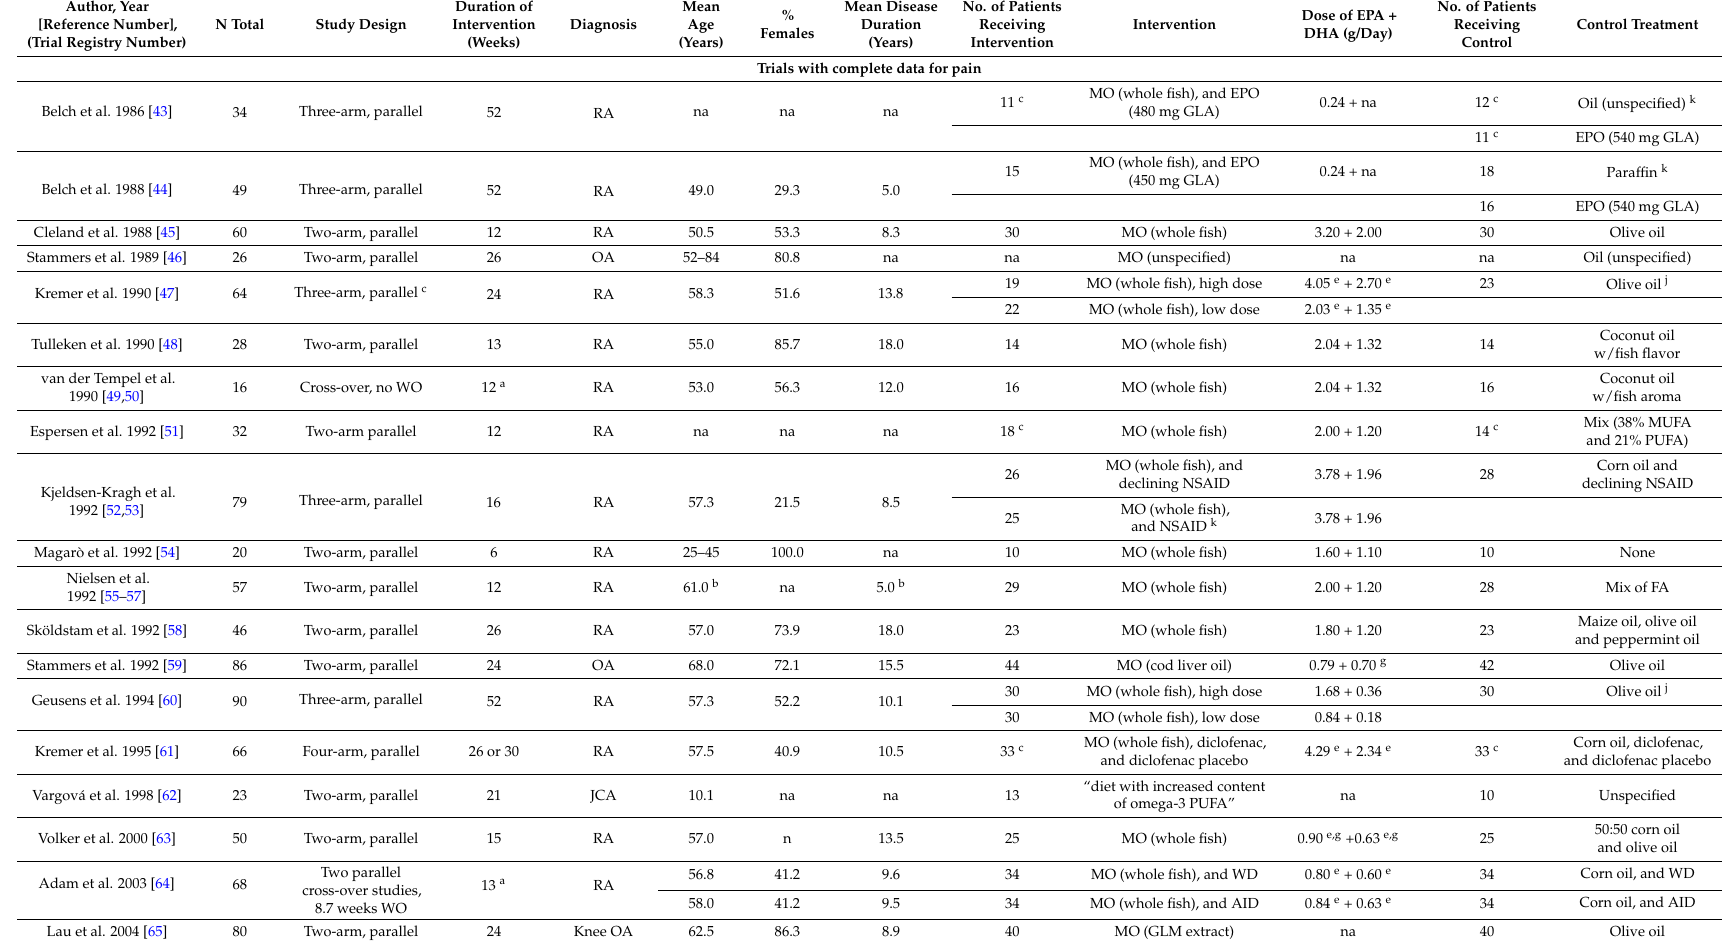
Table 1. Characteristics of the trials included in the meta-analyses trials presenting complete outcome data on pain are presented in the upper part of the